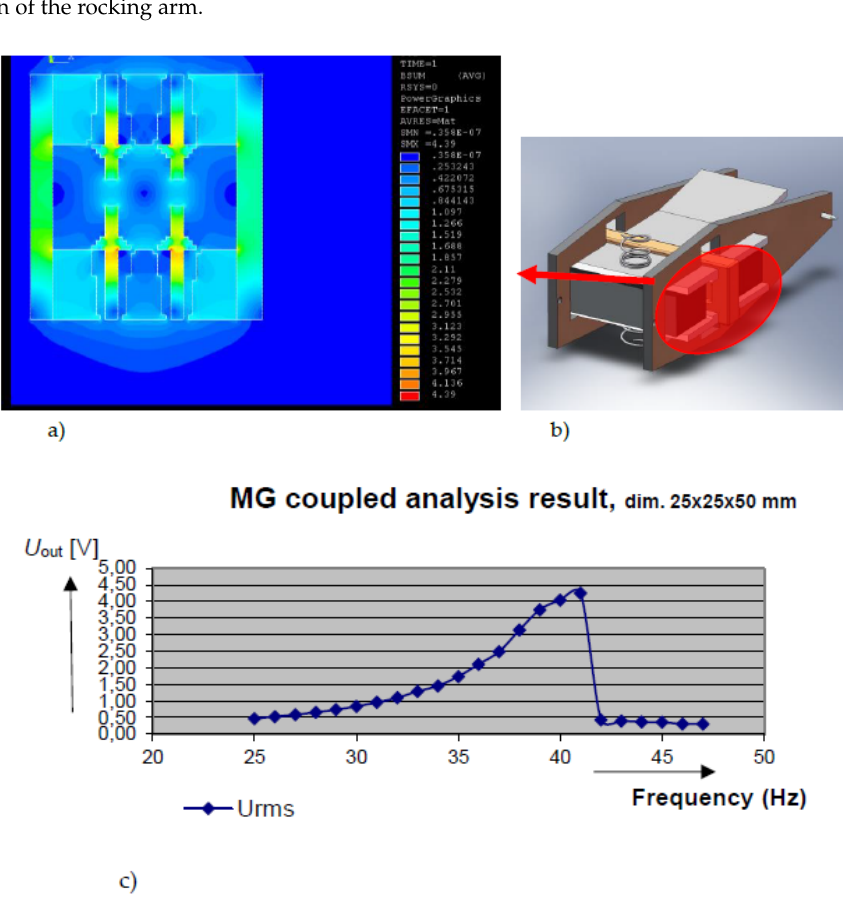
Figure 8. The example of the beam MG model magnetic field analysis ( a ), 2D detailed distribution of the magnetic flux density module B [T] ( b ) the modeled part of generator, ( c ) coupled 3D model analysis result, output -root mean square (RMS) voltage U out